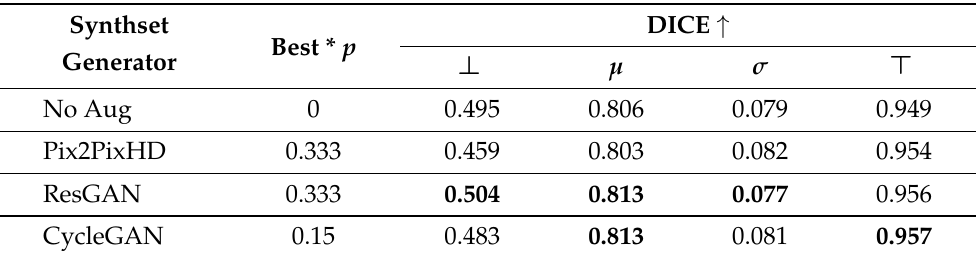
Table 3. Global segmentation test scores. Presents the minimum ( ( σ ) and maximum ( ) values of SSIM for the U-Net trained with the best synthset of each respective (cid:62) generator. The best no augmentation baseline ( No Aug ) is also